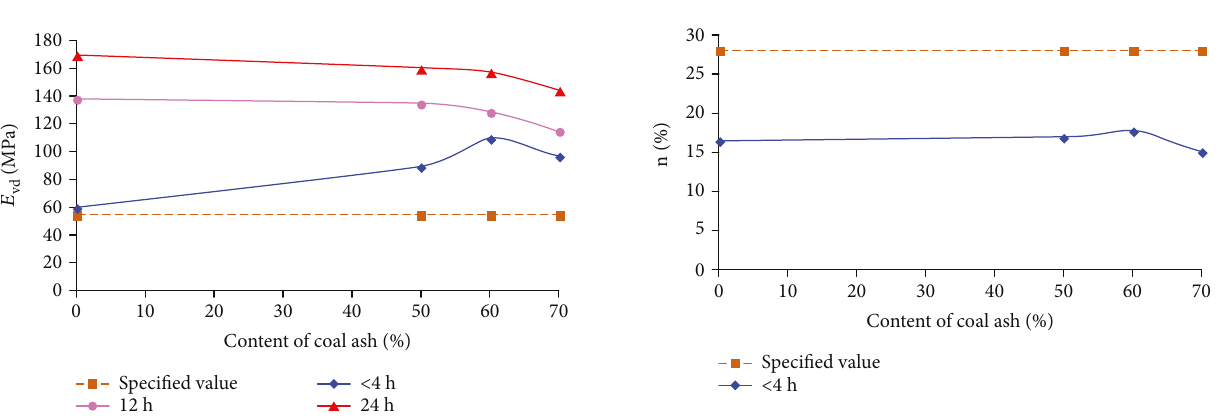
Figure 4: Relation diagram between porosity n and the content of coal